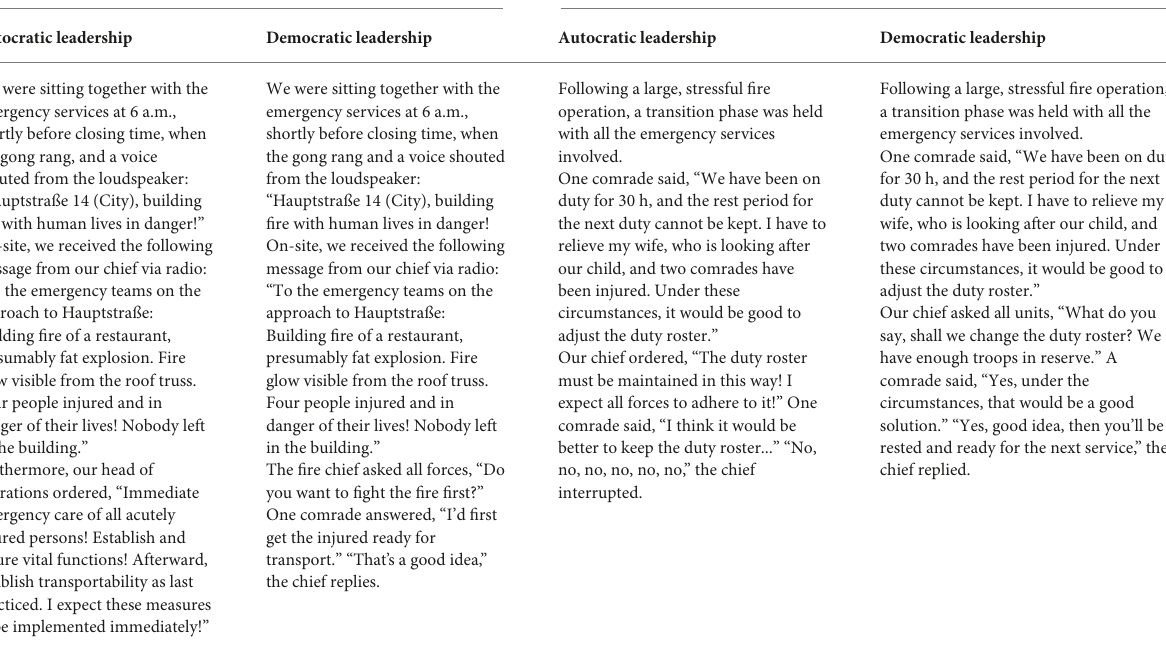
TABLE 1 Vignettes used in Study